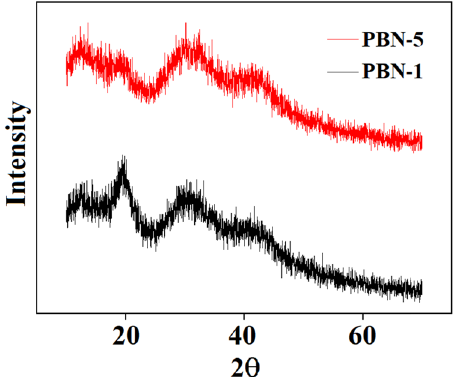
Figure 5: The XRD pattern of MMT - reinforced crosslinked PVA nano fi bers only and with 0.8 g of the root extract.